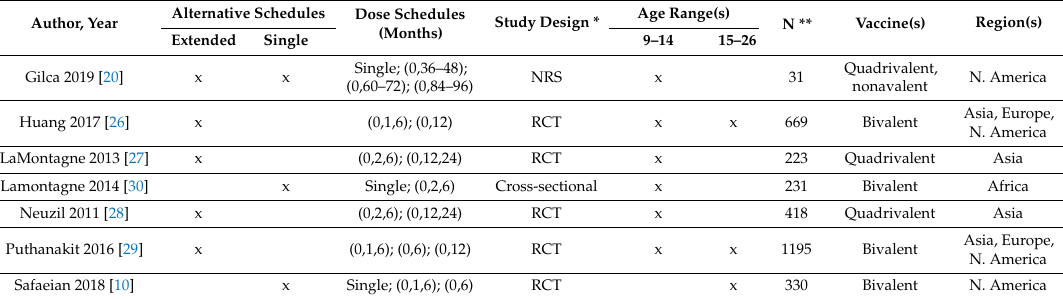
Table 1. Included single dose and extended interval studies.